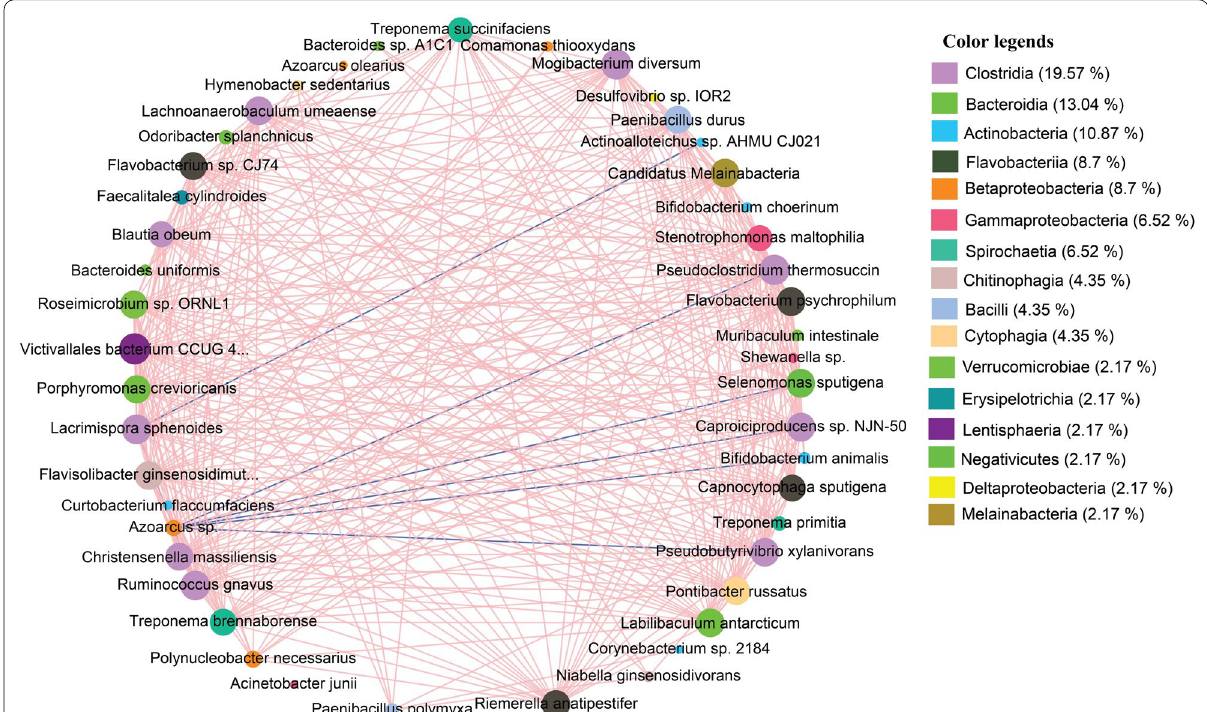
Fig. 6 Microbiome co-occurrence in both mastitis (MCMF and MCMMT) and healthy (HMF and HMMT) mice metagenomes. Network of co-occurring patterns among dominant species based on the Spearman’s (r > 0.5 and p < 0.01) correlation tests. Nodes represented dominant species and identified by different colors. The size of each node is proportional to the number of connections, and the thickness of each connection between two nodes (edge) is proportional to the value of Spearman’s correlation coefficients. The nodes are colored by phylum, and labels according to the taxonomic affiliations. The positive correlation (97.74%) is represented by the red lines while the blue lines represent negative correlation (2.26%). The more connections, the more association is associated with other members of the